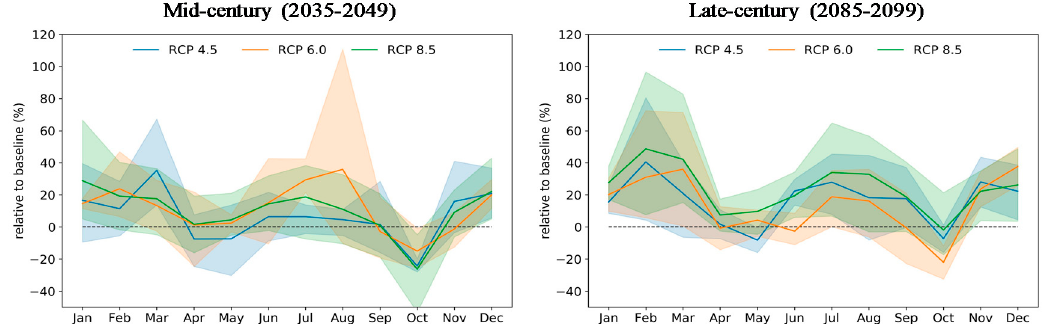
Figure 5. Seasonal variation of monthly precipitation during mid (2035–2049) and late century (2085–2099) relative to baseline period (1986–2000) for three RCPs (4.5, 6, and 8.5). The straight lines show the mean monthly precipitation, and the shaded area shows the range of the precipitation variation within the global climate models (GCMs).